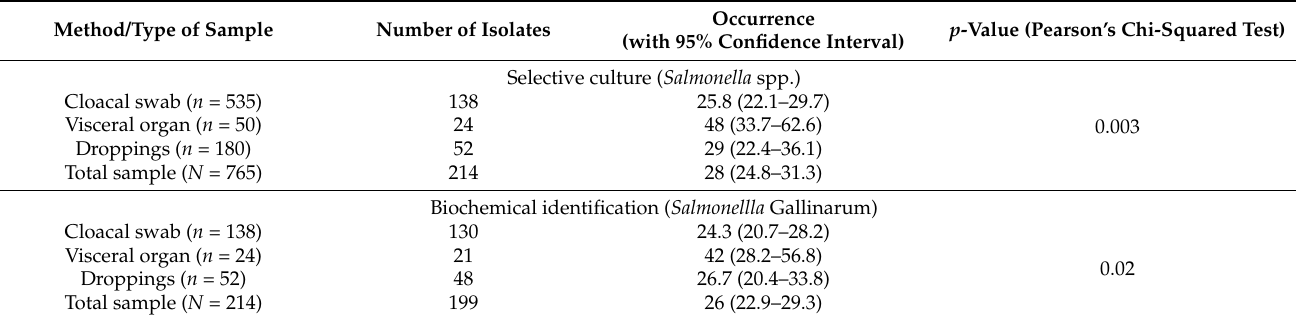
Table 2. Occurrence of Salmonella isolates, determined by selective culture and biochemical tests, in different samples collected from 12 layer flocks from 5 divisions of Bangladesh.